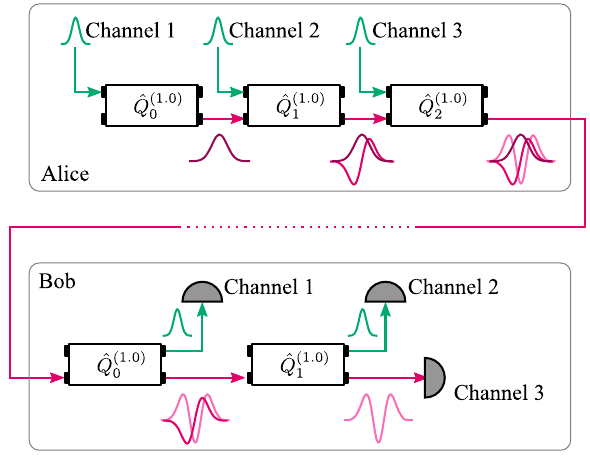
FIG. 10. In a TM multiplexing scenario, Alice uses orthogonal TMs as independent channels, which are sent to Bob in one single physical fiber. He demultiplexes the channels with QPGs and reads out the information. The QPGs are being employed as TM multiplexers (Alice) and demultiplexers (Bob) on a single-mode optical